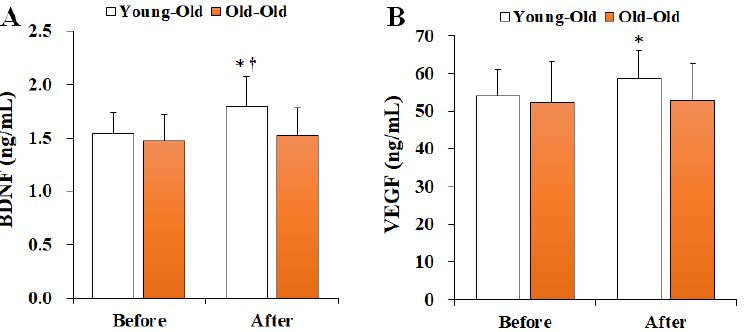
Figure 2. Changes in serum neurotrophic factor levels. Values presented by mean and standard deviation. ( A ) BDNF, brain-derived neurotrophic factor; ( B ) VEGF, vascular endothelial growth factor; * Significantly different versus Before ( p < 0.05); † Significantly different versus Old-Old group ( p < 0.05).